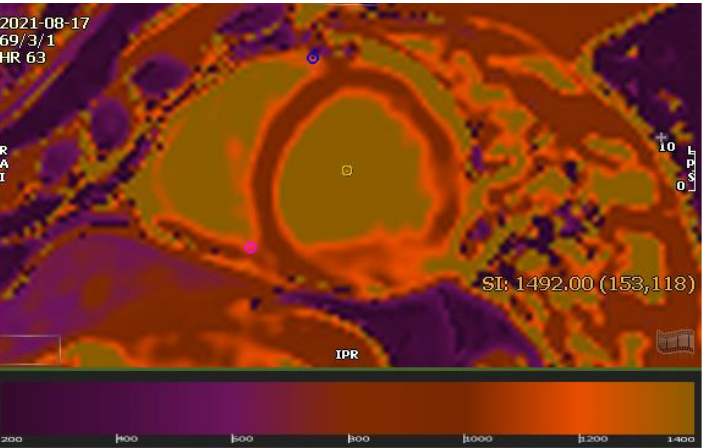
Figure 2. CMR imaging demonstrating T2w STIR 4 ch view with multiple increased signal intensity in anterolateral and lateral segments (arrow).